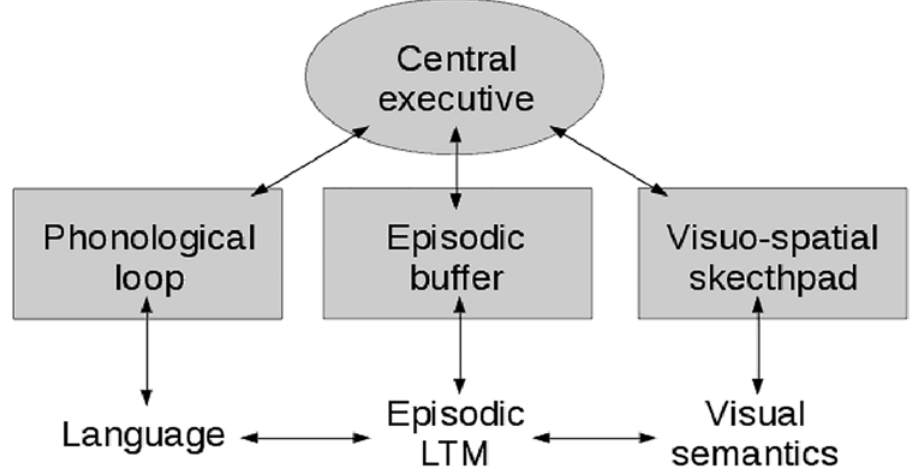
Fig 1. Baddeley's model of the working